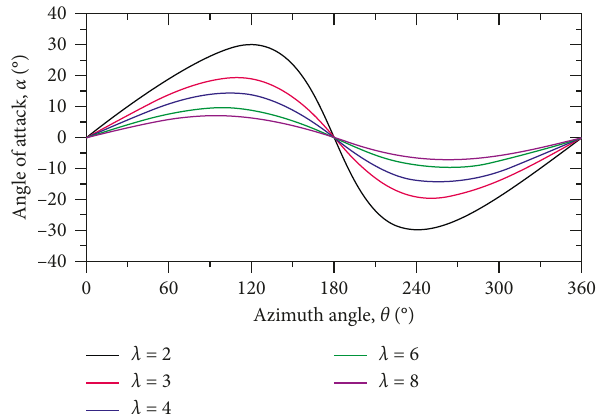
Figure 3: The change of azimuth angle θ with incident angle α for one revolution at various speed ratios λ